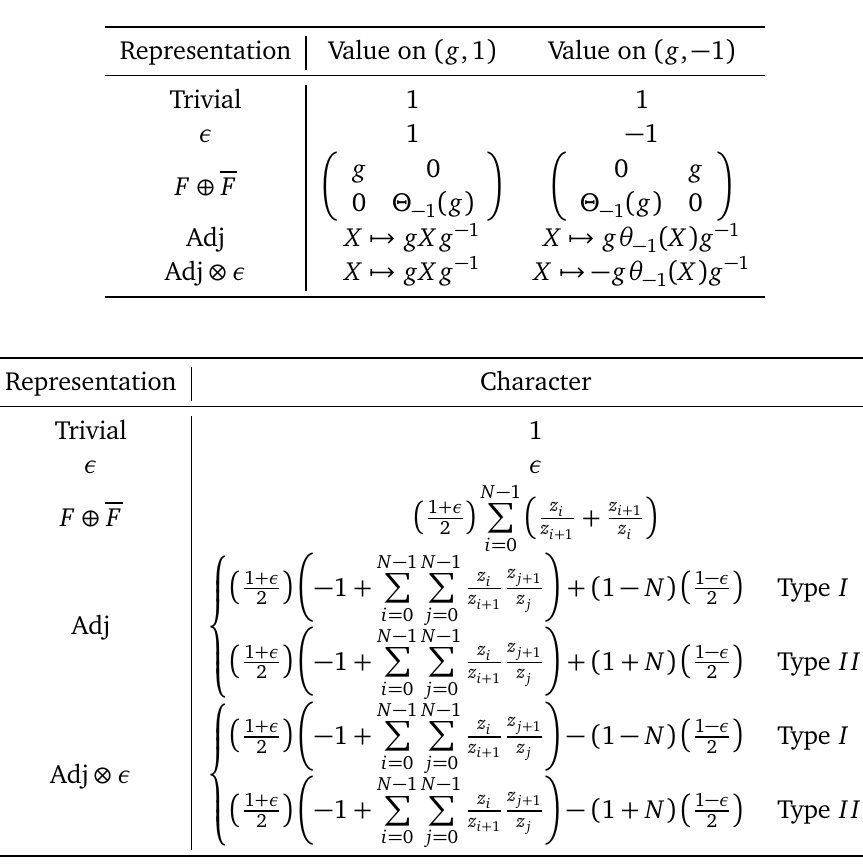
Table 2: The first table shows the representations of (cid:221) SU ( N ) used in the paper, by giv- ing the explicit action of elements of the form ( g , ε ) for ε = ± 1. For the 1-dimensional representations, this is a number; for the F ⊕ F representation we give a 2 N × 2 N matrix, and for the adjoint and ε -adjoint we give the action on an element X in the Lie algebra g . The second table gives the characters expressed in terms of fugacities ( z = z = ,..., z , ε ) ∈ T with the convention z N − 1 N 1 0